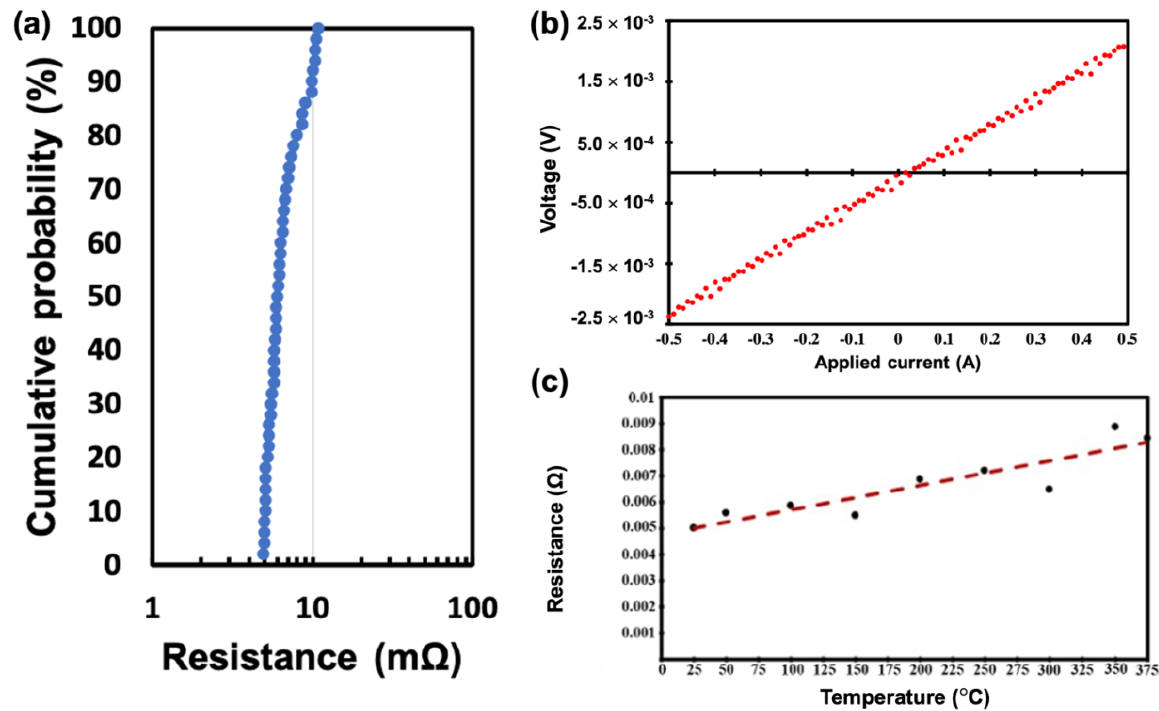
Figure 7. ( a ) Measured cumulative resistance for single Cu-Cu joint by four-point probes; ( b ) I–V curves; ( c ) Resistance against measured temperatures from 25 ° C to 375 ° C. Table 1. List of measured specific contact resistances from literature Ref. [24]